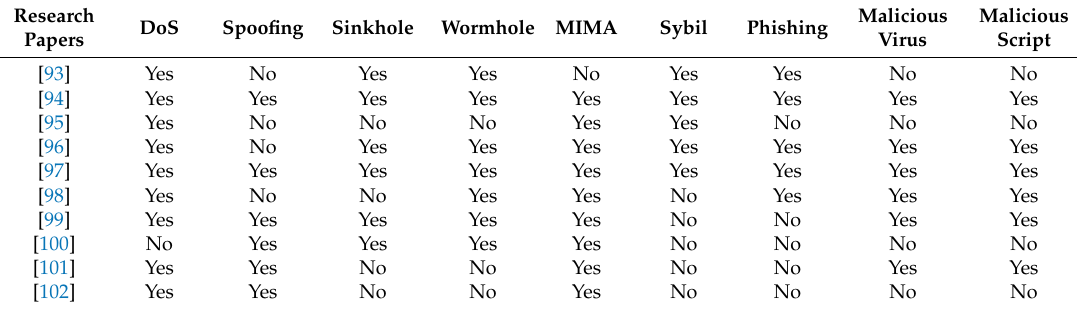
Table 9. Attacks on symmetric based encryption